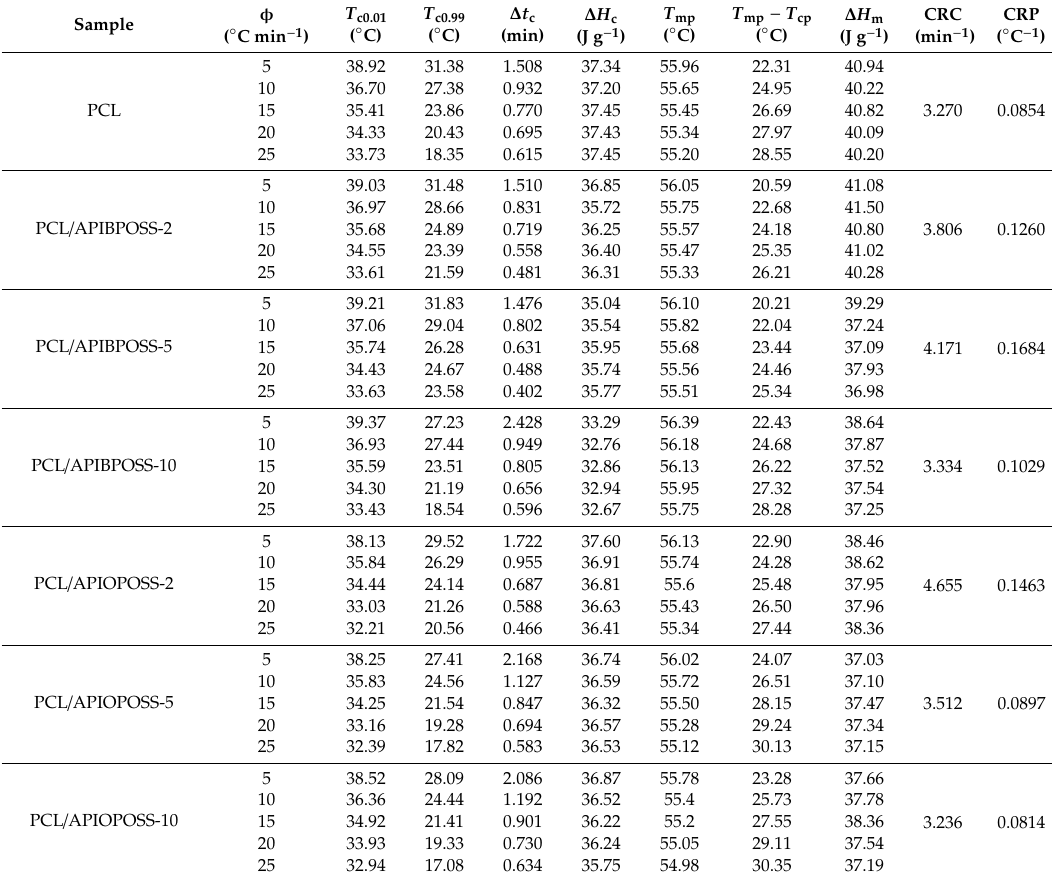
Di ff erential scanning calorimetry (DSC) results of pure poly( ε -caprolactone) (PCL), PCL / aminopropylisooctyl polyhedral oligomeric silsesquioxanes (APIBPOSS), and PCL / aminopropylisobutyl polyhedral oligomeric silsesquioxanes (APIOPOSS).